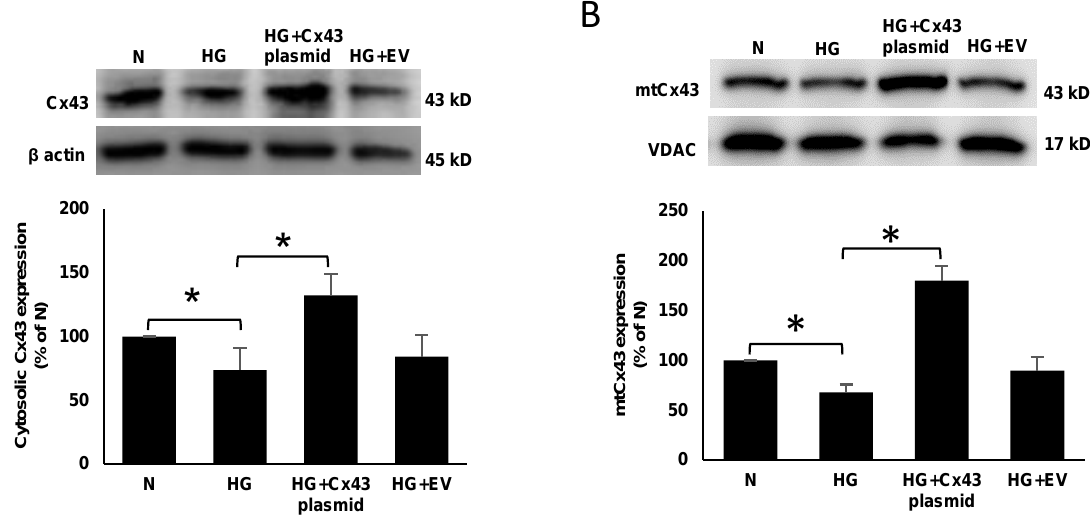
Figure 1. Cx43 plasmid transfection increases mtCx43 level in RRECs. Cytosolic Cx43 expression was significantly decreased in cells grown in HG medium compared to those grown in N medium. ( A ) Cells grown in HG and transfected with Cx43 plasmid significantly increased cytosolic Cx43 expression compared to those grown in HG medium. Bar graph shows cumulative data obtained from six experiments. ( B ) Cells grown in HG and transfected with Cx43 plasmid significantly increased mtCx43 level compared to those grown in HG medium. Bar graph shows cumulative data obtained from six experiments. Data are presented as mean ± SD, * p < 0.05; n =